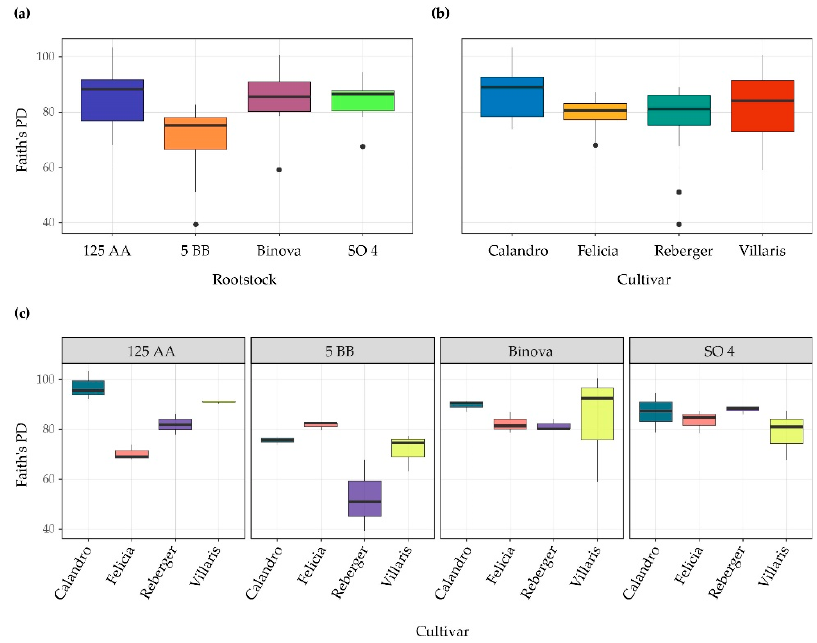
Figure 1. Faith’s phylogenetic diversity of bacterial rhizosphere communities per ( a ) cultivar, ( b ) rootstock and ( c ) the interaction between rootstock and cultivar.